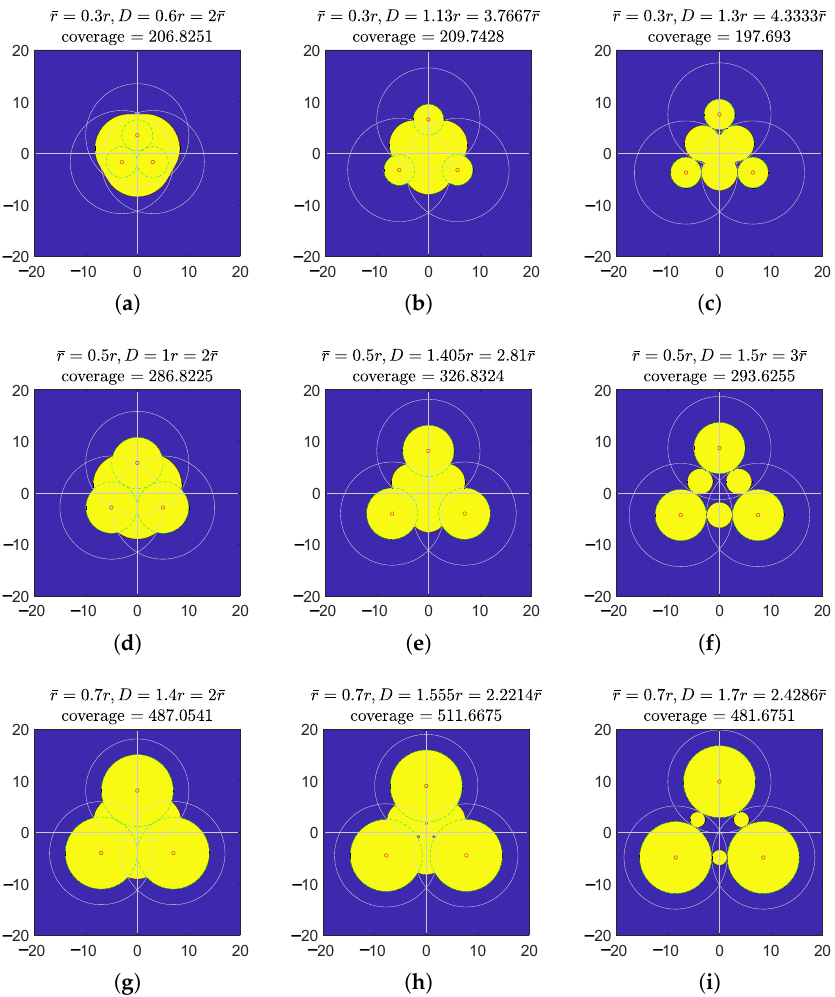
Figure 7. Illustration of resultant effective coverages of the 3-node team equipped with concave models I ( d ) = α ( r 2 − d 2 ) under different thresholds γ (intuitively reflected as ¯ r ). Each row represents one value of γ : they are ¯ r = 0.3 r ,0.5 r ,0.7 r , respectively. Each column represents a different separation distance D : the first column ( a , d , g ) is the “tangent column”, where the individual effectively covered regions in light green dashed circles are tangent to each other, i.e., D = 2¯ r ; the second column ( b , e , h ) is the “max column”, where the team’s effective coverage is maximized with corresponding separations D ; the third column ( c , f , i ) shows configurations where D = r + ¯ r . r = 10. α =